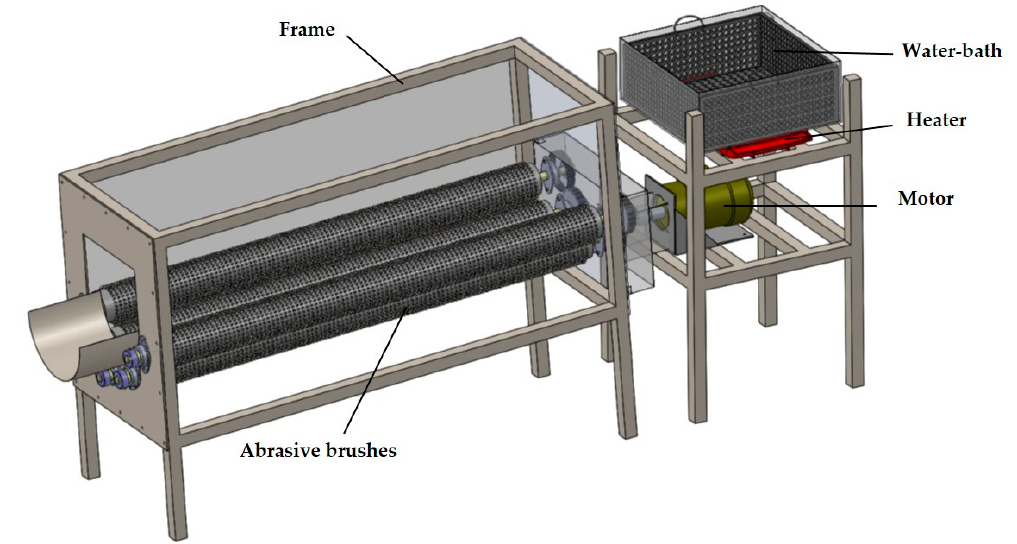
Figure 1. The prototype cassava peeling machine.